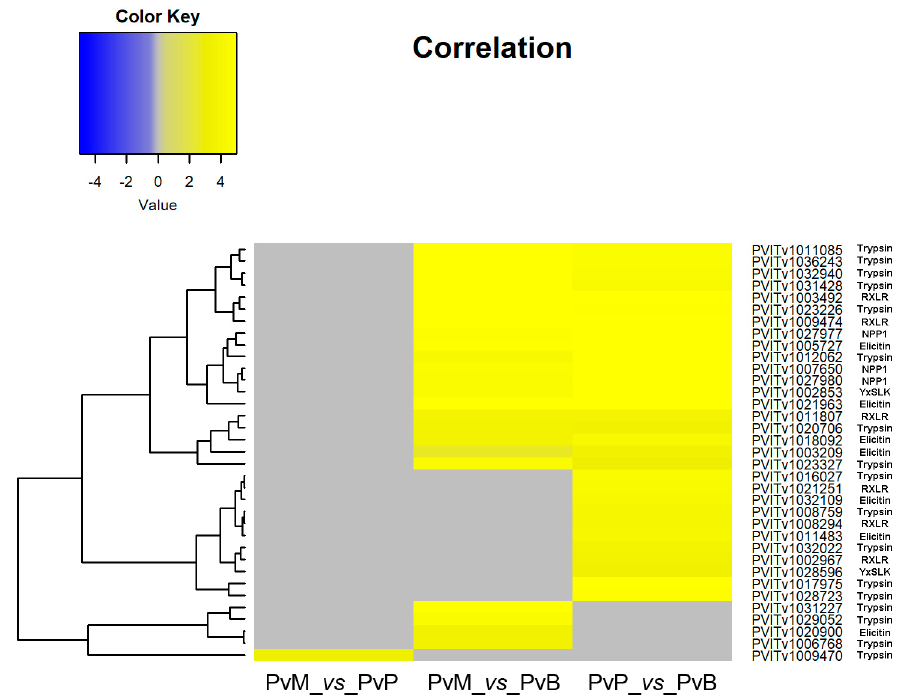
Figure 2. Heatmap of 35 genes encoding cytoplasmic (RXLR and YxSLK) and apoplastic effectors (trypsin, elicitin and NPP1) differentially expressed by Plasmopara viticola (Pv) following inoculation on Mgaloblishvili (M) and Pinot noir (P) (PvM_ vs _PvP), M and Bianca (B) (PvM_ vs _PvB), and P and B (PvP_ vs _PvB).